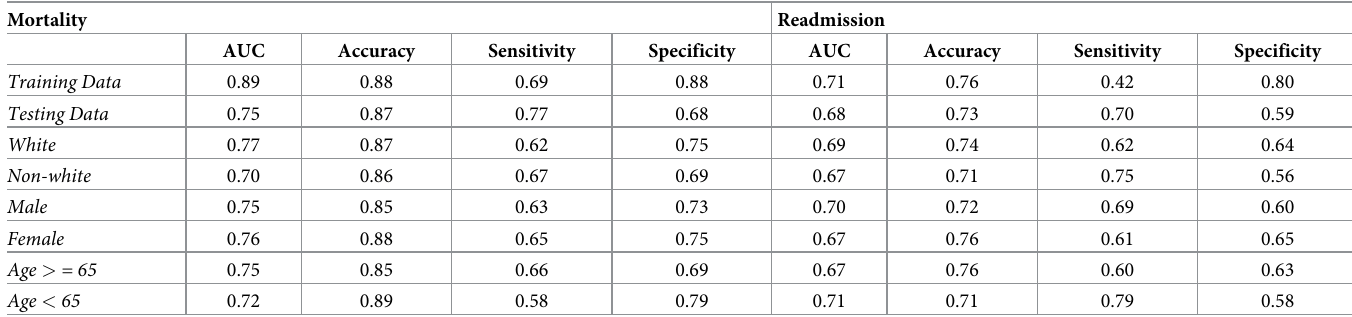
Survival analysis on subgroups obtained from the top five identified predictors for 30-day mortality by Gini impurity shows significant differences in survival time between those who had physiological high-risk factors (p < 0.001), those who underwent elective versus non-elec- tive procedures (p < 0.001), those who were independent versus those who were totally or par- tially dependent (p < 0.001), HCT < 30% versus HCT of 30% or greater (p < 0.001), and those who had serum creatinine at levels indicating CKD stage 1 or 2 versus those with serum creati- nine at levels indicating CKD stage 3 or above (p < 0.001). Survival analysis of subgroups obtained from the top five most important predictors for 30-day readmission shows significant differences in readmission time between those who had an open wound/wound infection ver- sus those who did not (p < 0.001), those who were undergoing a major reintervention of the treated arterial segment versus those who were not undergoing reintervention (p < 0.001), those underwent elective surgery versus non-elective procedures (p < 0.001), those with clau- dication versus those without claudication (p < 0.001), and those with diabetes versus those without diabetes (p < 0.001). Survival curves for 30-day mortality and 30-day unplanned read- mission are pictured in S1 Fig.